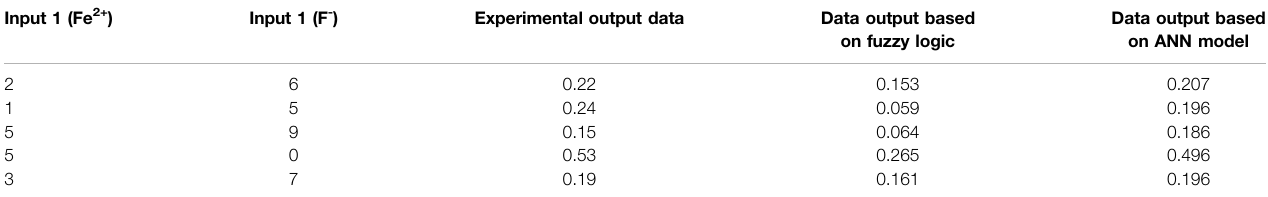
TABLE 3 | Experimental, fuzzy, and ANN model data in the presence of different combinations of inputs. Input 1 (Fe 2+ ) Input 1 (F -